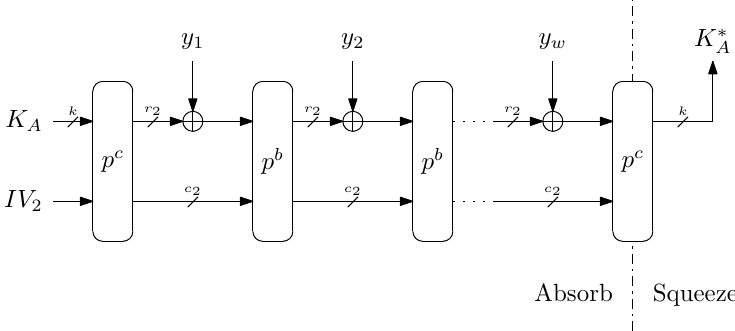
Figure 3: IsapRk used to process the master key K A